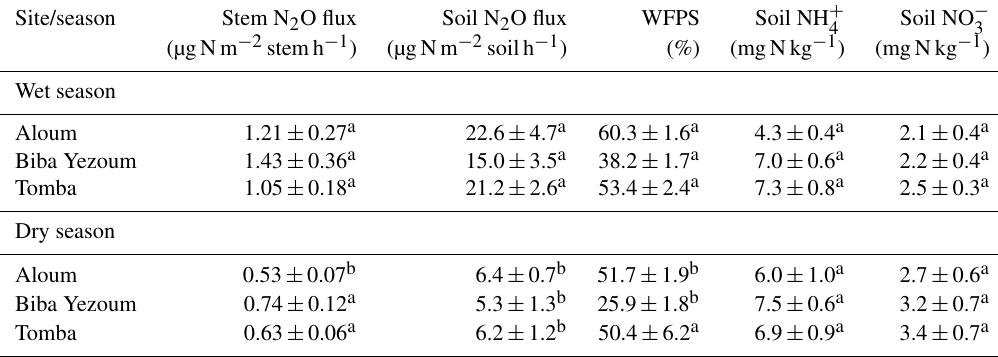
Table A4. Seasonal mean ( ± SE, n = 4) water-filled pore space (WFPS), extractable mineral N (measured in the top 5cm of soil) and nitrous oxide (N 2 O) fluxes in cacao agroforestry sites located on highly weathered soils in the Congo Basin, Cameroon. Means followed by different lowercase letters indicate significant differences between seasons for each site (linear mixed-effect models with Tukey’s HSD at P ≤ 0 .